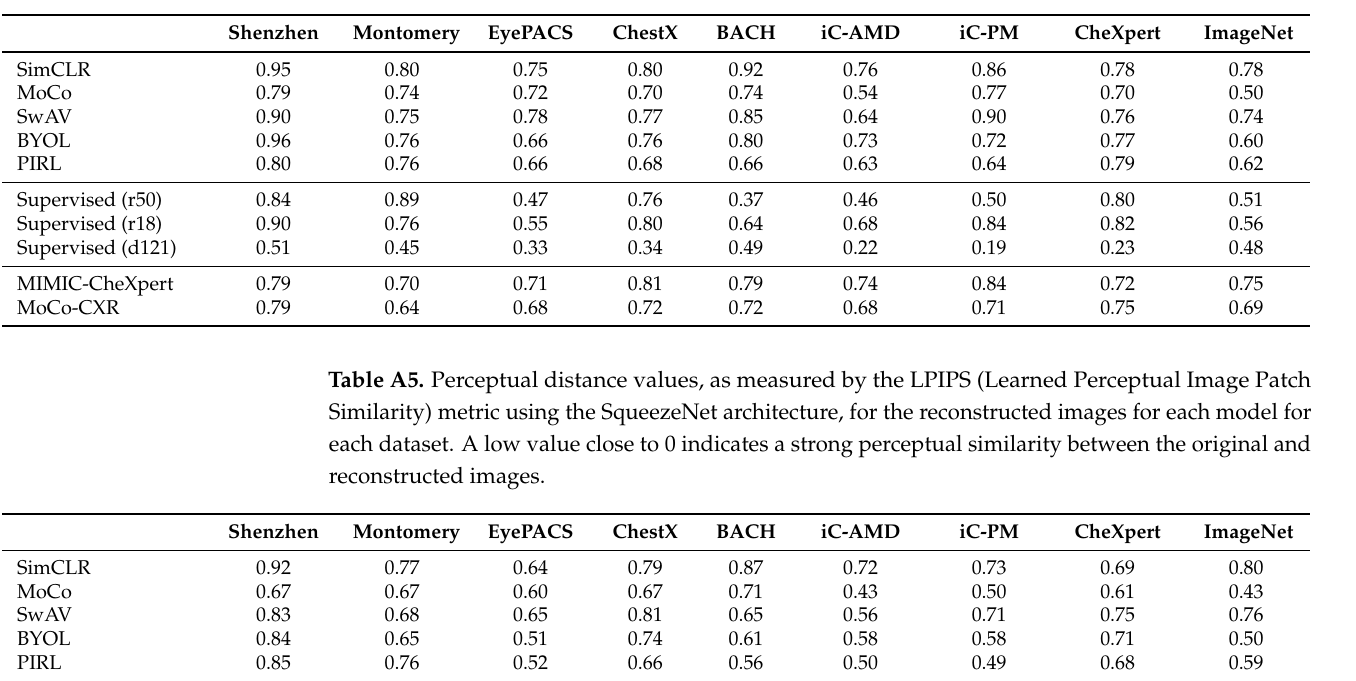
Table A4. Perceptual distance values, as measured by the LPIPS (Learned Perceptual Image Patch Similarity) metric using the AlexNet architecture [47], for the reconstructed images for each model for each dataset. A low value close to 0 indicates a strong perceptual similarity between the original and reconstructed images.